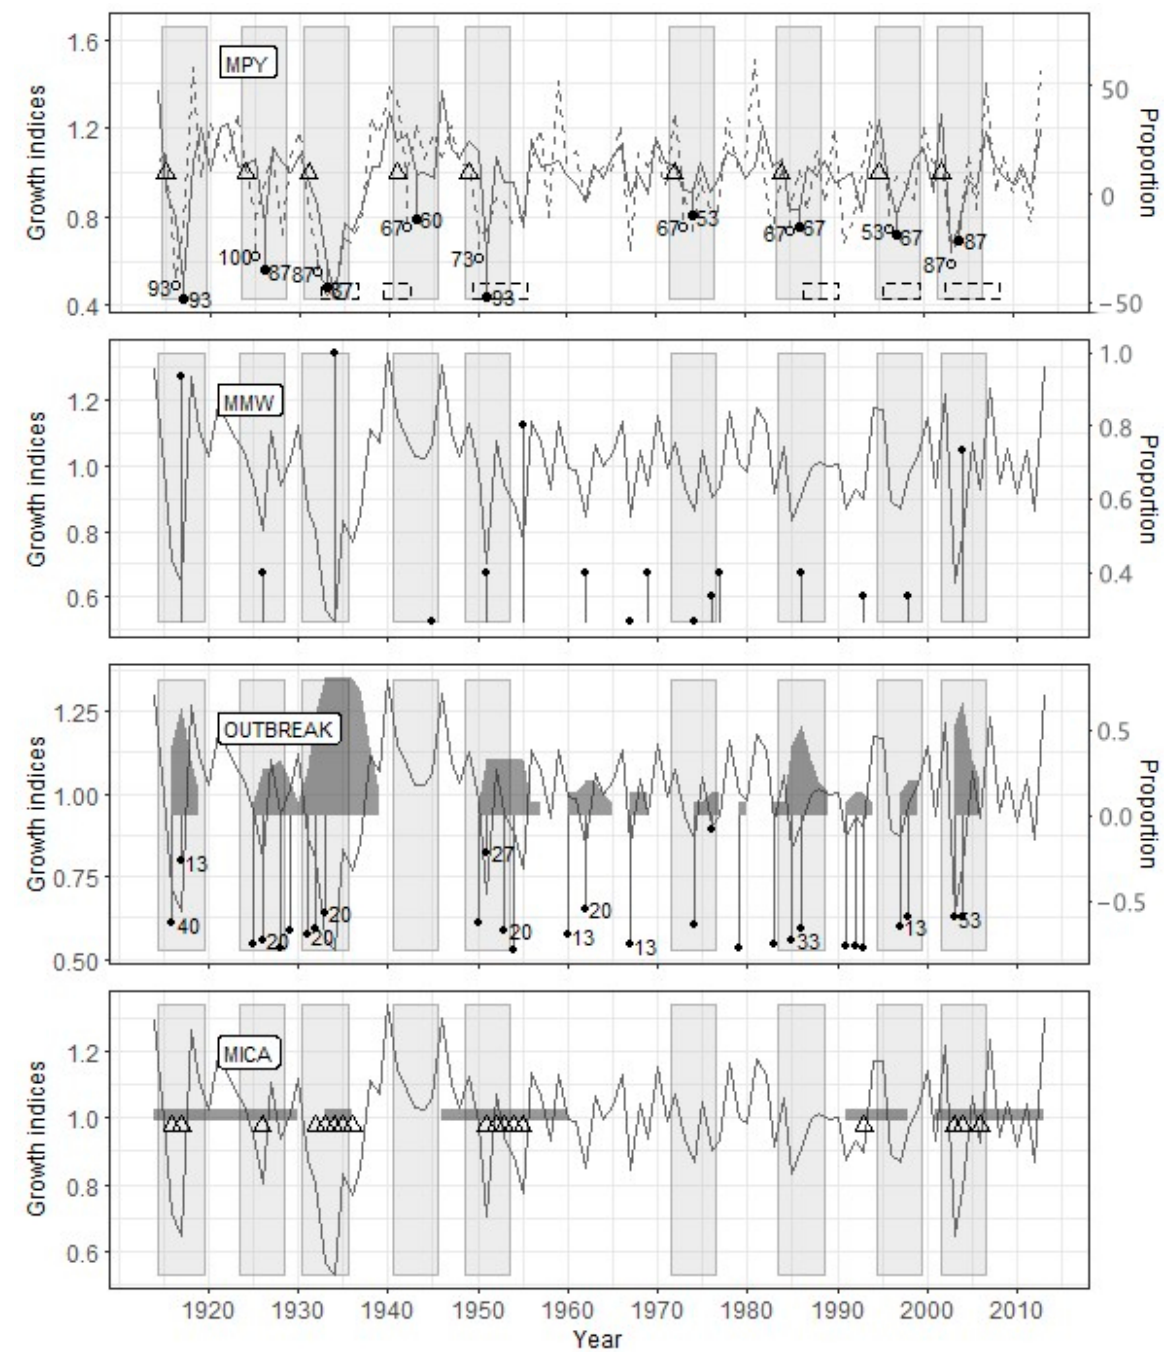
Figure 4. Reconstruction results for the Sokolovo site. Legend as for Figure 3.